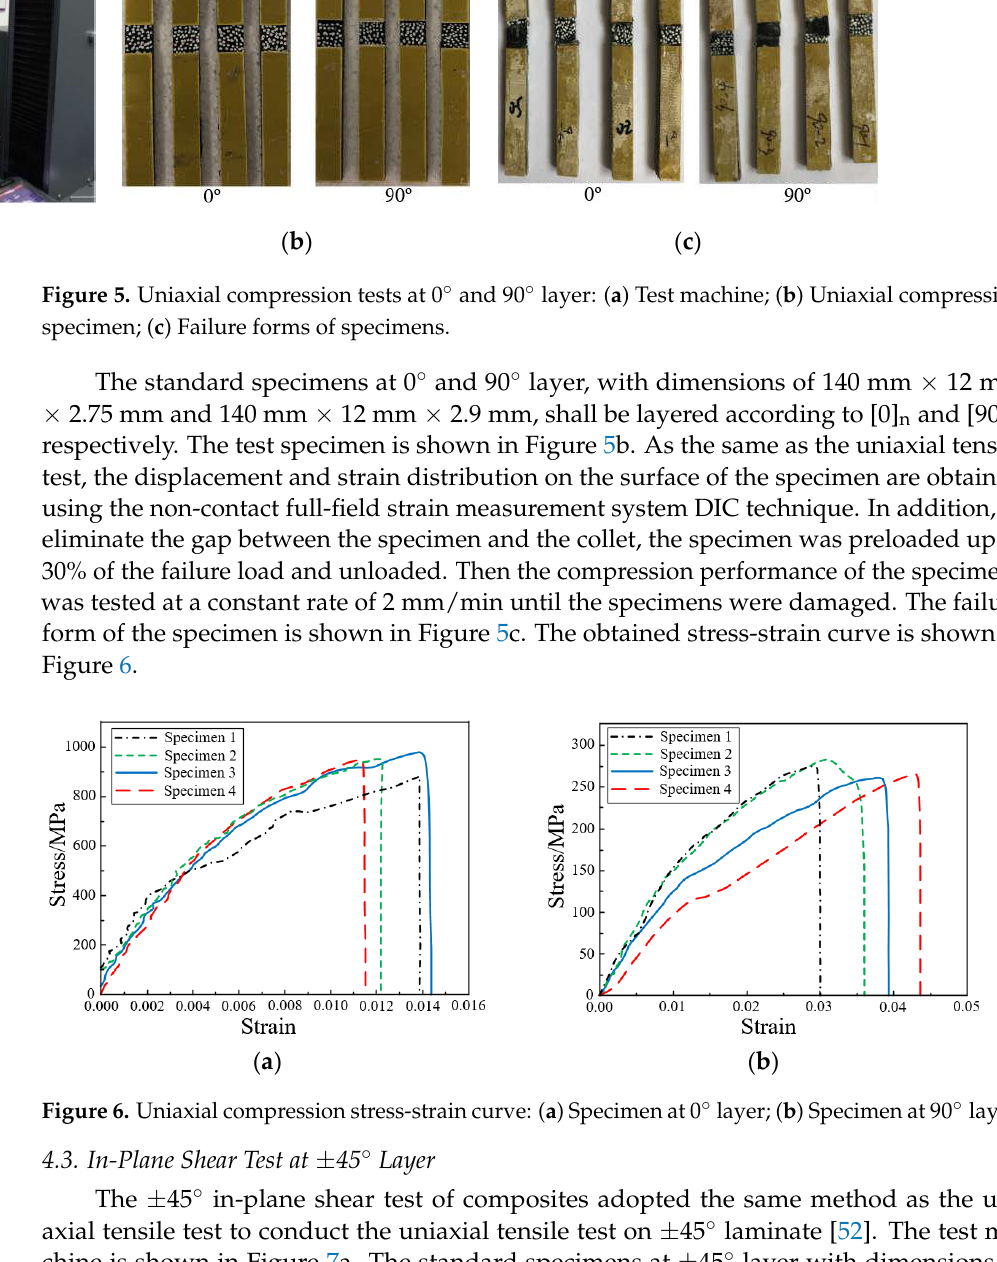
Figure 6. Uniaxial compression stress-strain curve: ( a ) Specimen at 0° layer; ( b ) Specimen at 90° layer.